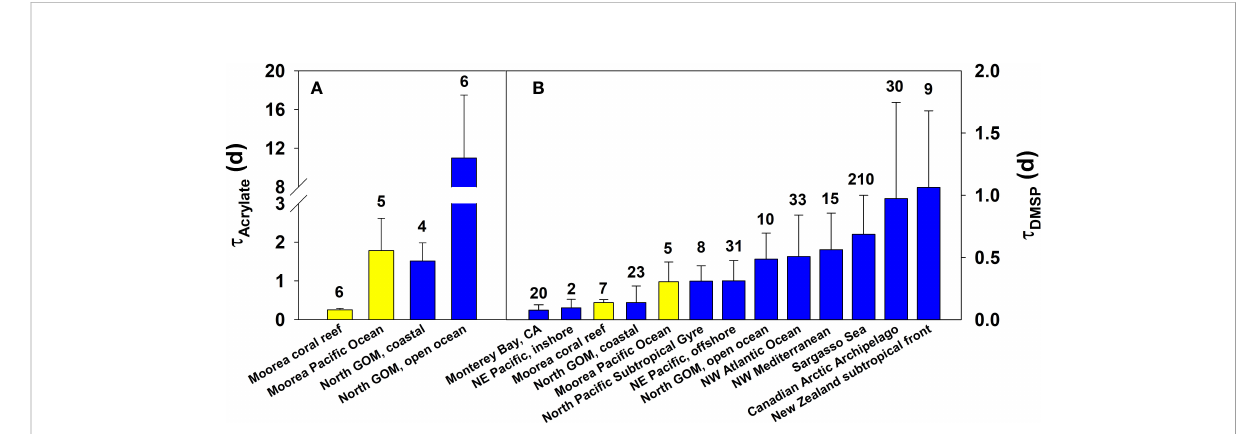
FIGURE 8 Turnover time ( t ) of (A) acrylate d and (B) DMSP d from their biological consumption determined in our study (yellow- fi lled bars) and in previously published studies (blue- fi lled bars) from different marine environments across different seasons. The value above each bar depicts the number of samples from each study area, which may include multiple studies.